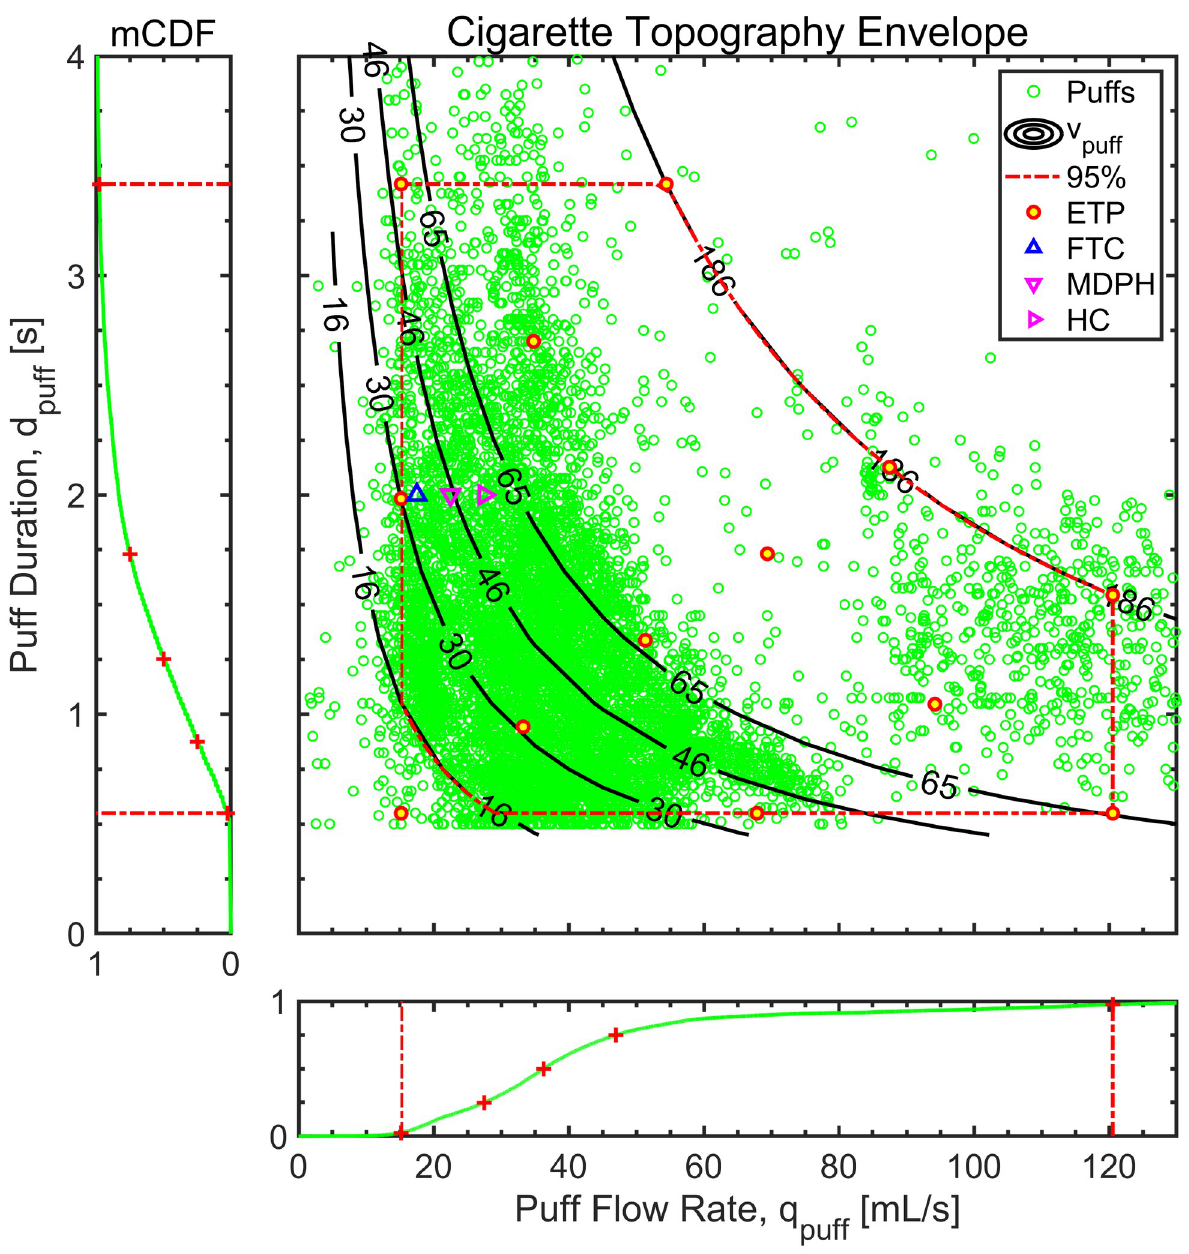
Fig 3. Puff topography distribution (N = 8,250 puffs) of (N = 26 smokers) of cigarette smokers in their natural environment during a week- long observation period. The ‘+’ represent 2.5 th , 25 th , 50 th , 75 th , and 97.5 th percentiles in the marginal cumulative distribution of puff duration and flow rate. Lines of constant volume are shown for the 2.5 th , 25 th , 50 th , 75 th , and 97.5 th in the mCDF of puff volume. The red circles illustrate the recommended emissions topography protocol (ETP) representing smokers in the natural environment. Participants ranged from occasional smokers (less than daily) to an upper limit of ½ pack per